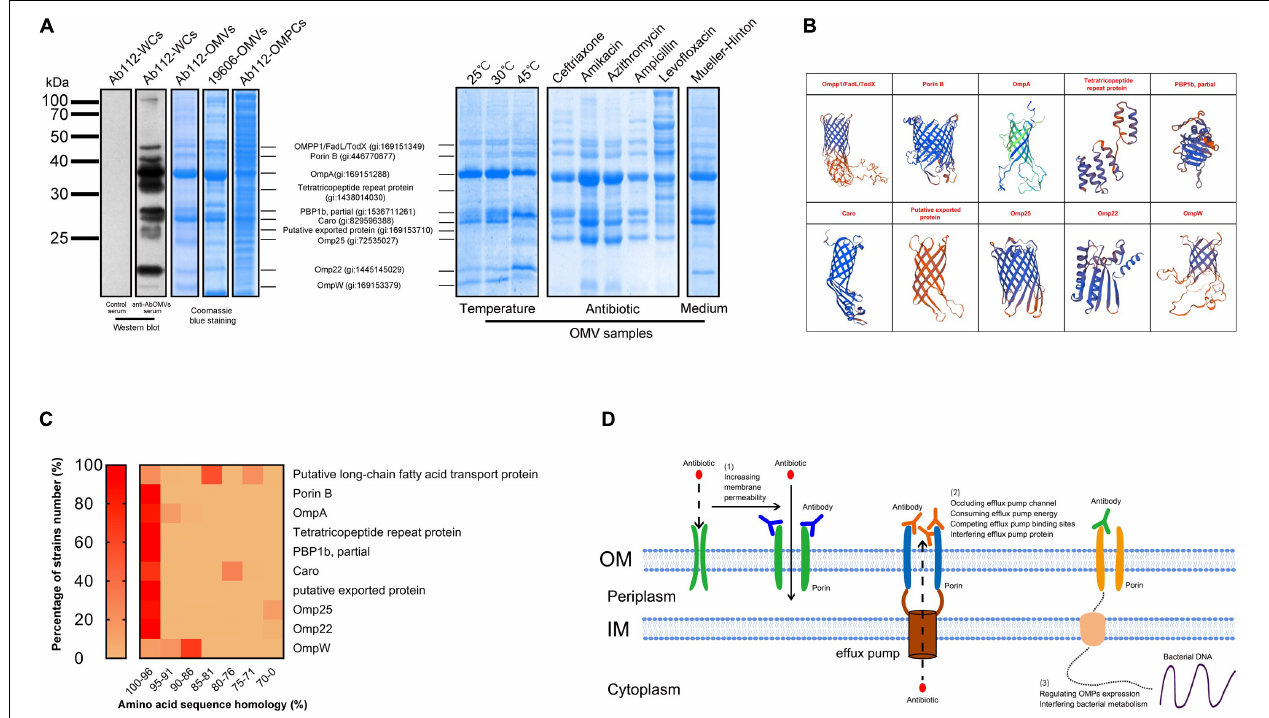
FIGURE 6 | The anti-AbOMV antibodies increased the intracellular aggregation of antibiotics by affecting the porins. (A) The immune reaction of anti-AbOMV and control serum with the Ab112 strain was detected by Western blotting; Ab112 OMPCs, 19606-OMVs, and Ab112-OMVs prepared under different culture conditions were detected by SDS-PAGE, and mass spectrometry was used to analyze the corresponding proteins detected by Western blotting. (B) The model of the identified proteins was built using the SWISS-MODEL automated protein structure homology-modeling server (http://swissmodel.expasy.org). (C) BLAST was used to analyze the amino acid sequence homology of the 10 proteins with approximately 2832 reported A. baumannii strains. The heat map shows the homology (displayed in %) of each protein with the proportion (%) of all A. baumannii strains. The homology was divided into seven intervals (100–96%, 95–91%, 90–86%, 85–81%, 80–76%, 75–71%, and 70–0%). (D) Schematic diagram of the mechanism by which anti-AbOMV antibodies increase the intracellular aggregation of